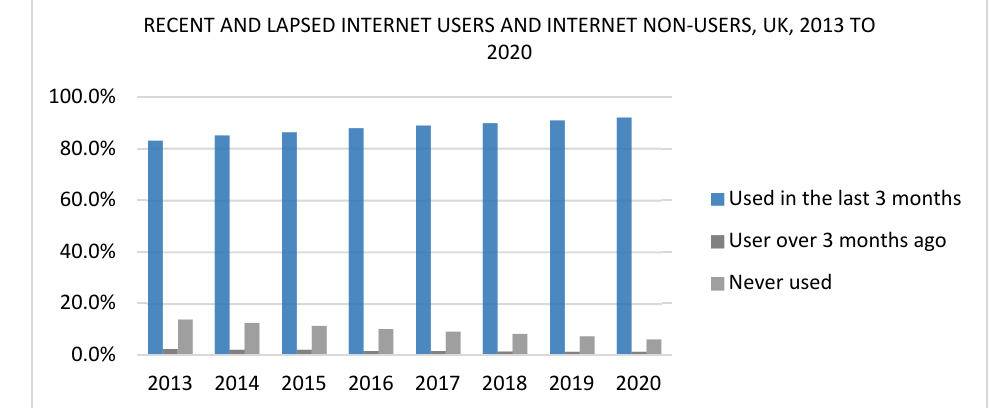
Figure 1. Recent and lapsed internet users and internet non-users, UK, 2013 to 2020